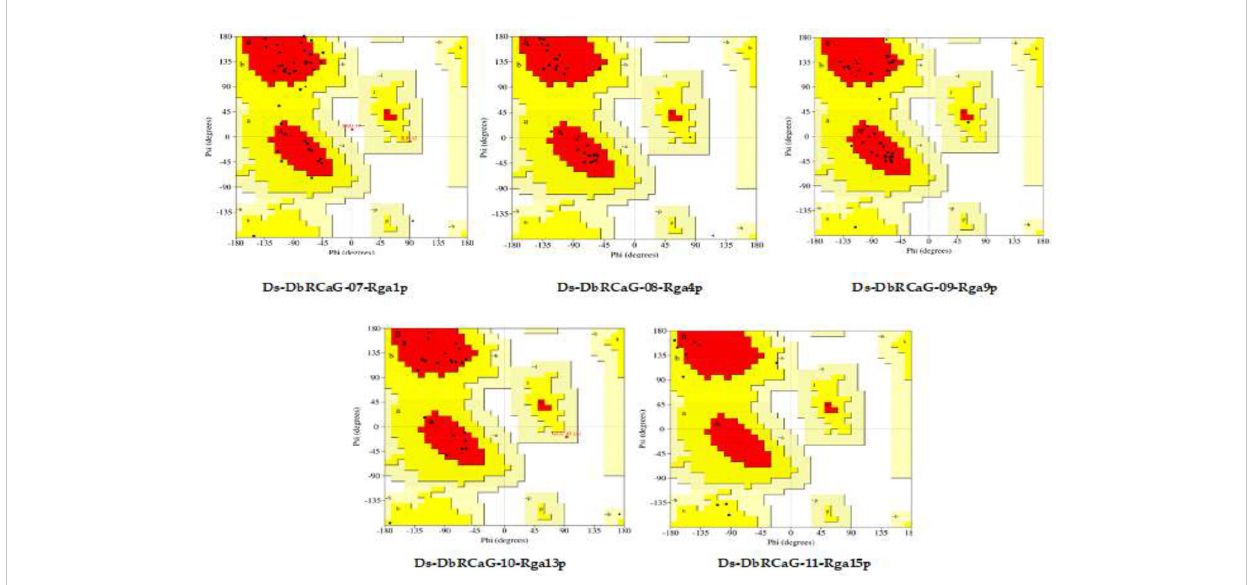
FIGURE 1 Ramachandran plots of Ds-DbRCaG-07-Rga1p, Ds-DbRCaG-08-Rga4p, Ds-DbRCaG-09-Rga9p, Ds-DbRCaG-10-Rga13p, and Ds-DbRCaG-11- Rga15p. The most favored region is shown in red, the additionally allowed region in yellow, the generously allowed region in pale yellow, and the additionally allowed region in